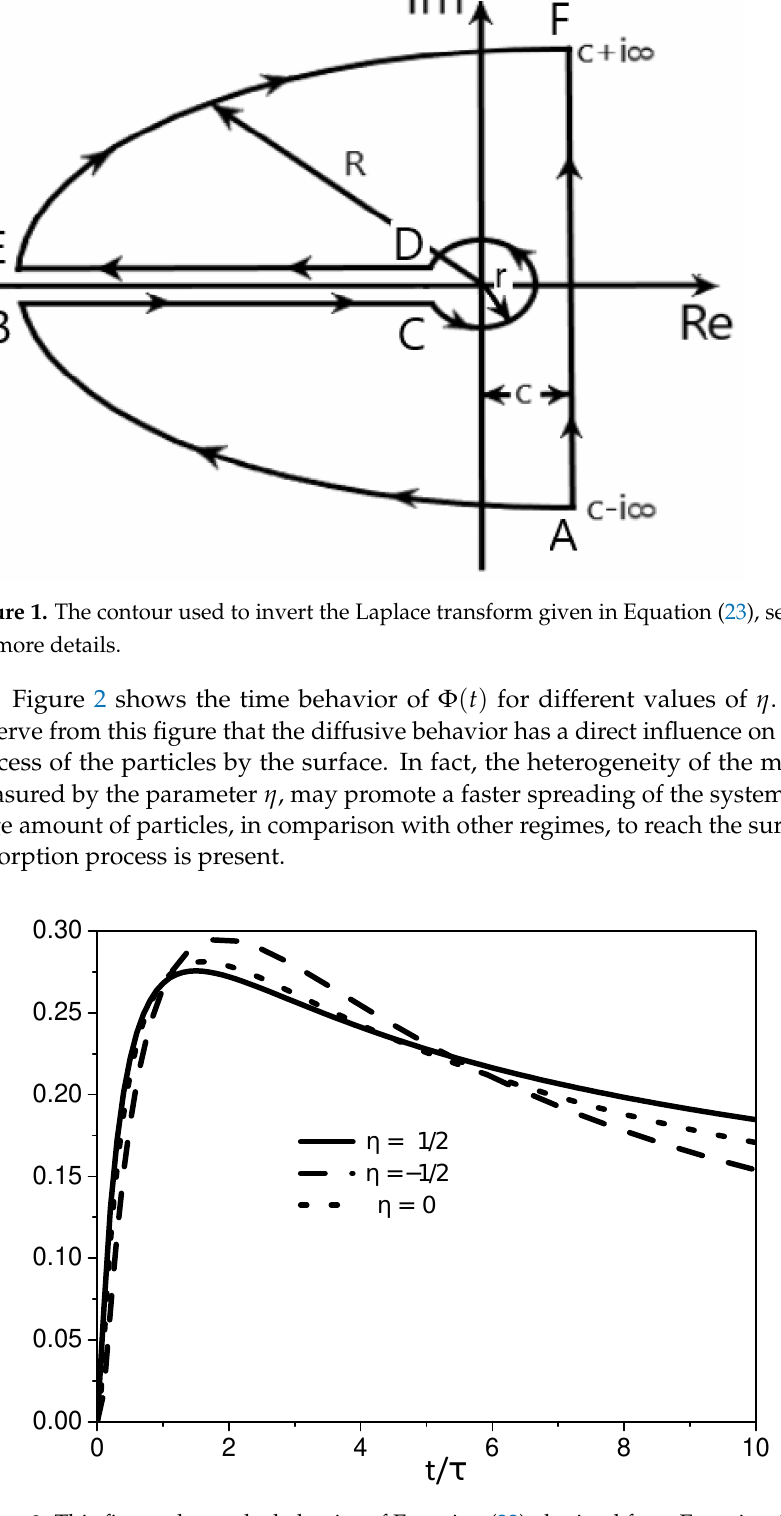
Figure 2. This figure shows the behavior of Equation (22) obtained from Equation (19) for different values of η , where κ ( t ) = κδ ( t ) and ϕ ( x ) = δ ( x − x (cid:48) ) . It is possible to verify that the choice of η has a direct influence on the asymptotic behavior of Φ ( t ) . We consider, for simplicity, ¯ κ = 1, x (cid:48) = 1/2, and D τ =